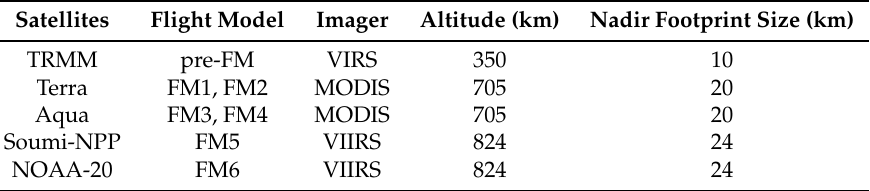
Table 1. List of CERES instruments on different